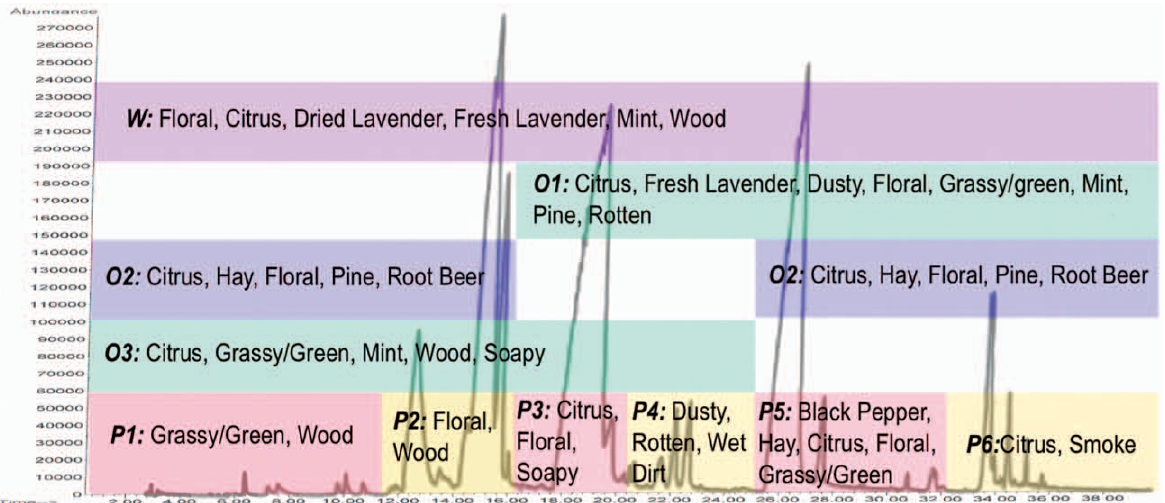
Figure 3. Top aroma descriptors for mixtures of sections of the lavender chromatogram by cut time and chromatogram composition. Abbreviations correspond to Experimental Conditions described in Table 1. As chemical complexity and number of components per mixture approaches the makeup of the whole chromatogram (W) mixture, there is evidence of perceptual additivity as increasing cross-utilization of terms from simpler mixtures, masking as reduced use of dominant terms for simpler (P1–P6) mixtures, and synergistic effects as new complex or composite terms like ‘‘fresh lavender’’ become important.